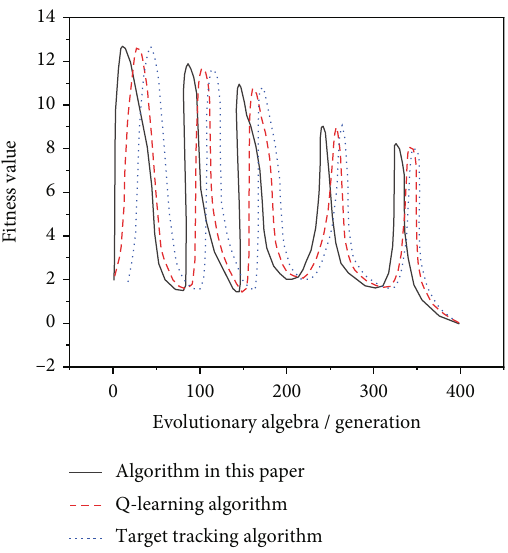
Figure 7: Evolution process of moving to